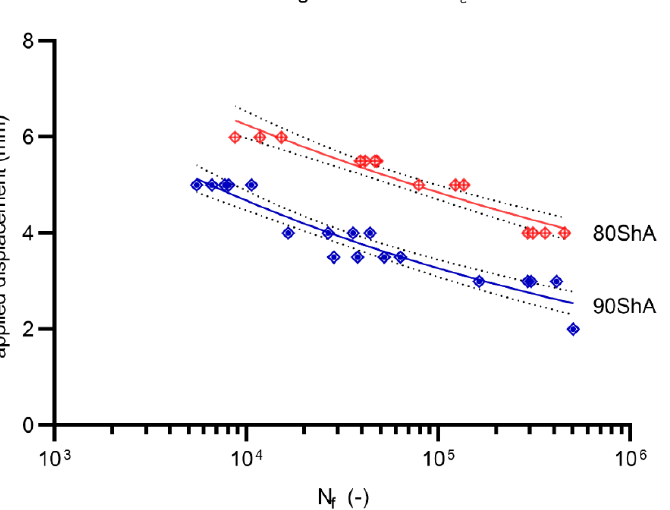
Figure 16. Displacement control mode fatigue data for R = 0 (80 ShA and 90 ShA).